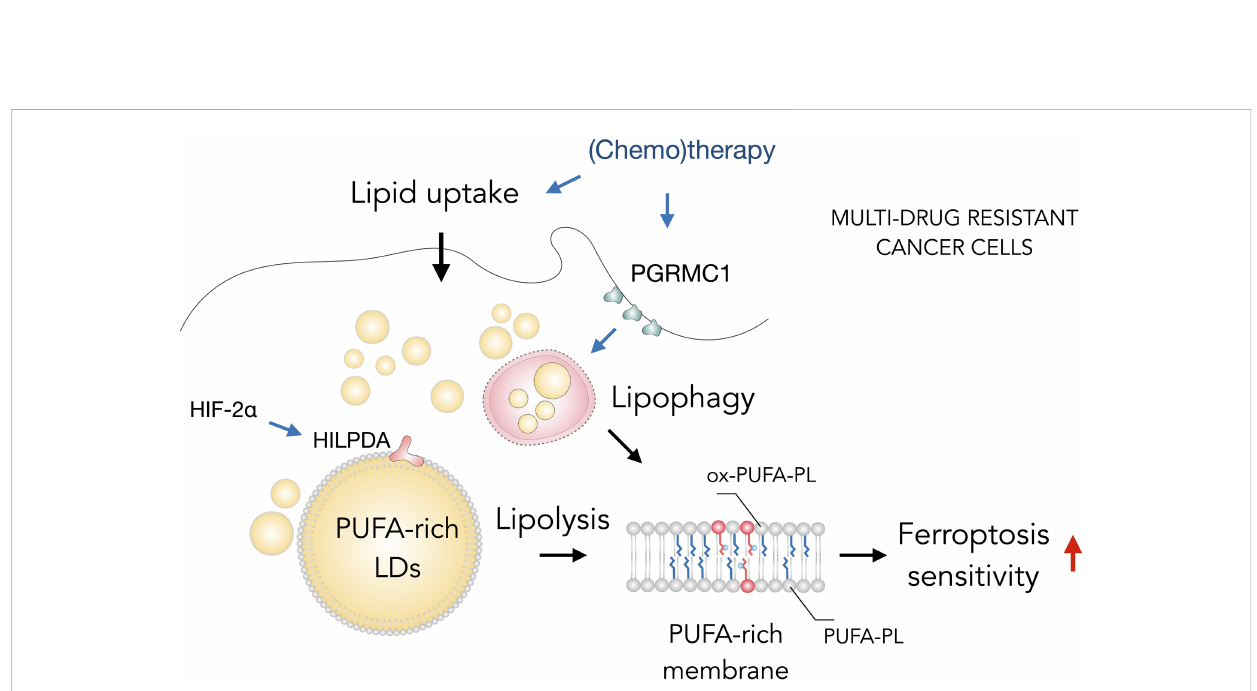
FIGURE 4 Lipiddroplets(LDs)sensitizedrug-resistantcancercellstoferroptosis.Theacquisitionofmultidrugresistantstatesincancercellsisaccompaniedby widespread metabolic remodeling and activation of various signaling pathways, including increased lipid uptake, progesterone receptor membrane component 1 (PGRMC1) overexpression and activation of the hypoxia-inducible factor 2 alpha (HIF-2 α )/hypoxia-inducible LD-associated protein (HILPDA)axis,whichpromotetheaccumulationofpolyunsaturatedfattyacid(PUFA)-enrichedtriglyceridesandcholesterylestersstoredwithinLDs. These LDs may contribute through lipolysis and lipophagy to the enrichment of membrane phospholipids with PUFAs (PUFA-PLs). PUFA-PLs are easily oxidized during oxidative stress giving rise to various oxidized phospholipid species (ox-PUFA-PLs) that impair membrane function and may further propagate membrane lipid peroxidation, which can sensitize cells to